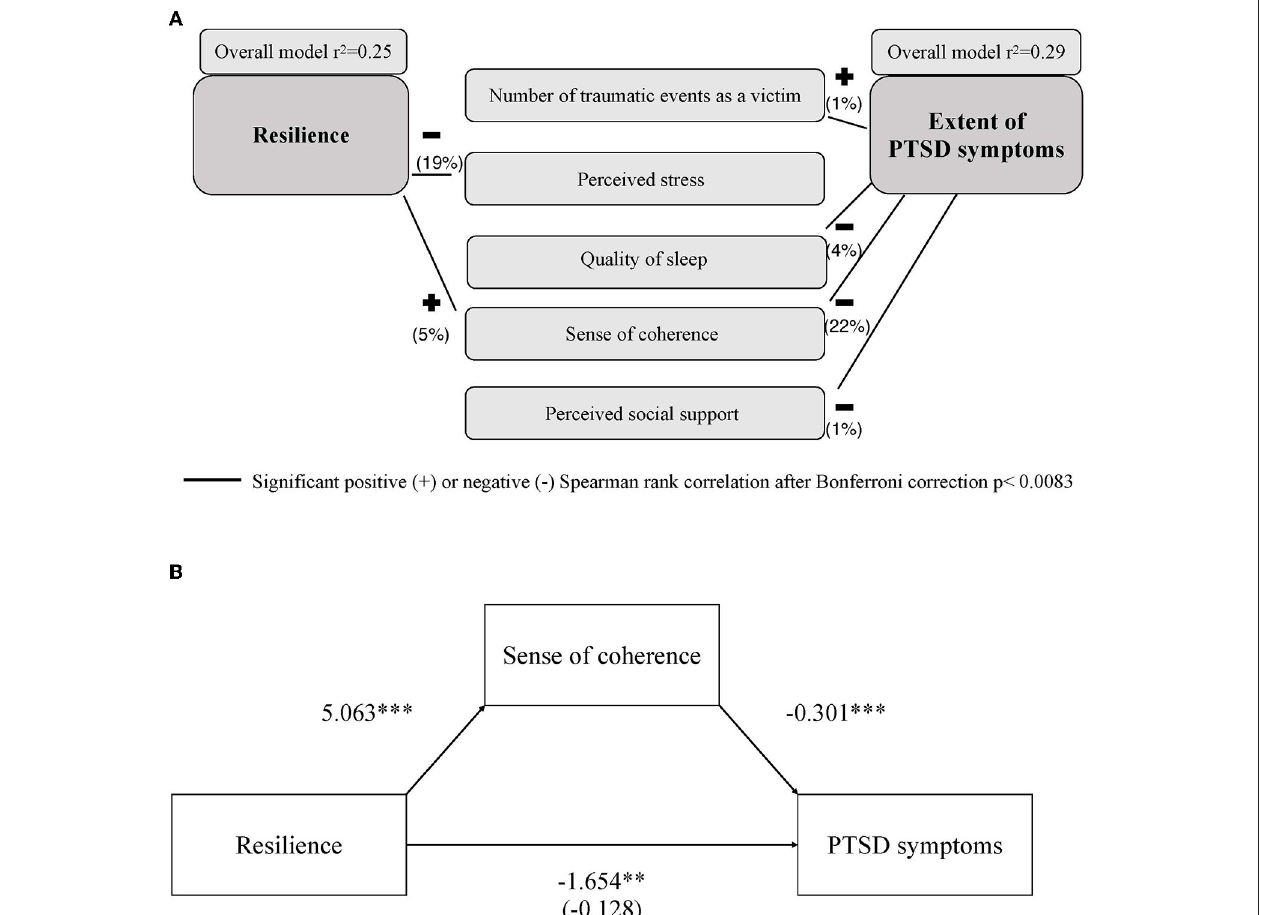
FIGURE 2 | (A) Depicts the predictive model of resilience (left) and severity of PTSD symptoms (right). Black lines indicate the positive and negative Spearman rank correlations of resilience and severity of PTSD symptoms with the variables included in the respective models. Numbers in brackets indicate the explained variance of the individual predictive factors. (B) Shows the mediation model of sense of coherence (mediator) between resilience (predictor) and severity of PTSD symptoms (dependent variable). ** p < 0.01, *** p < 0.001.